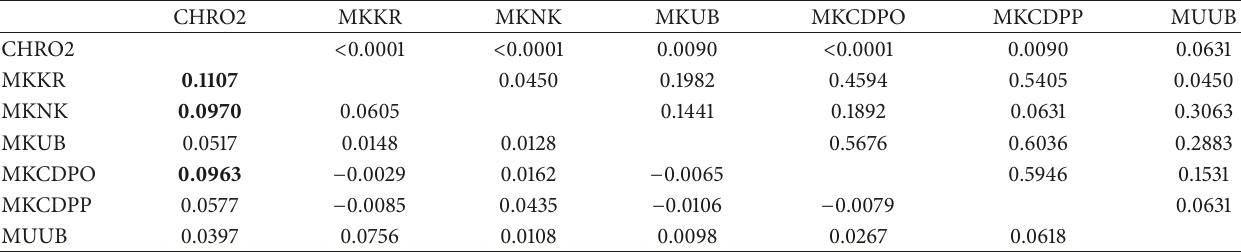
Table 2: Pairwise 𝐹 ST (below diagonal) and associated 𝑃 value (above diagonal) between populations of Belodontichthys truncatus collected during August–November 2014 in Thailand and Cambodia. Population codes are according to Table 1. CHRO2 MKKR MKNK MKUB MKCDPO MKCDPP MUUB 0.1107